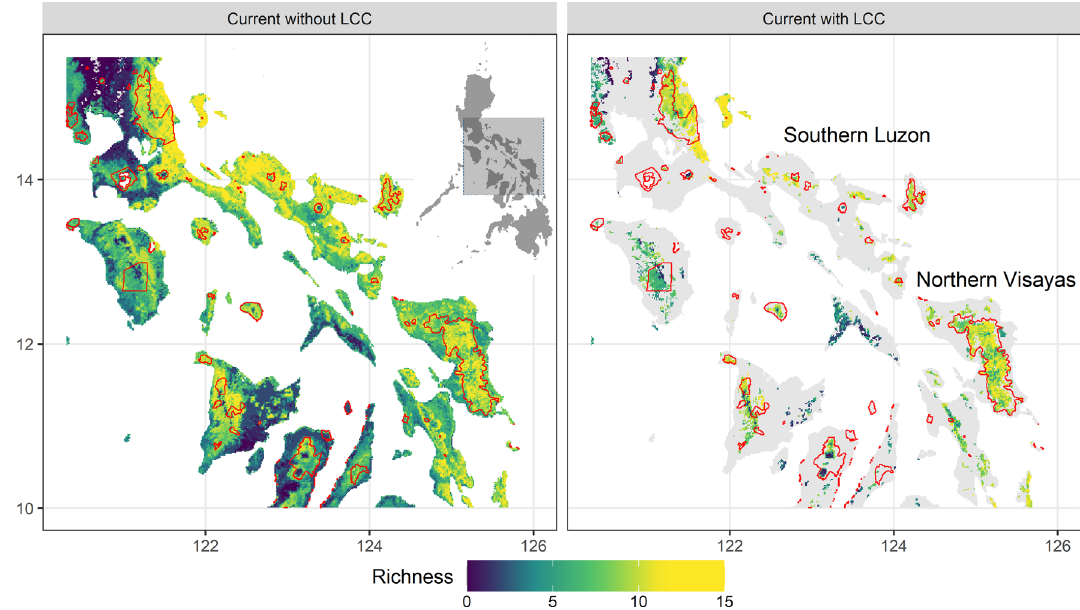
Figure 1. The effects of LCC on the current distribution of suitable habitat for 19 dipterocarps for southern Luzon and northern Visayas, Philippines, which was the region in the Philippines projected to have the largest distribution of species rich suitable habitats. The viridis colours indicate dipterocarp richness—lighter colours indicated higher richness and darker colours indicated lower richness—and protected areas were demarcated in red. The maps were created in R using the raster and ggplot2 package 66,67,121